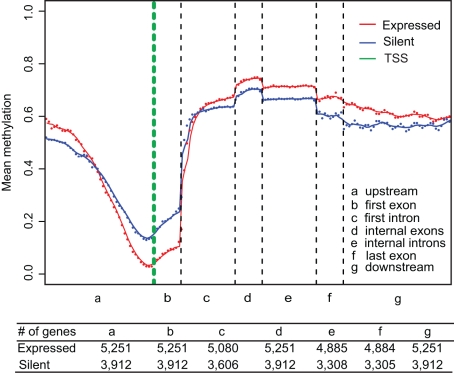
Canonical DNA methylation profiles of expressed and silent genes in PBMC.Expression status was determined by digital gene expression profiling (DGEP). Genes with ≥5 DGEP tags were defined as expressed (n = 5,251, color-coded red). Genes with no DGEP tag were defined as silent (n = 3,912, color-coded blue). The canonical gene structure is defined by 7 different features, denoted by the x-axis. The length of each feature was normalized and divided into equal numbers of bins. Each dot denotes the mean methylation level per bin and the respective lines denote the 5-bin moving average. Each feature was analyzed separately for the numbers listed in the table below the figure. The green vertical line indicates the mean location of the transcription start sites (TSS).